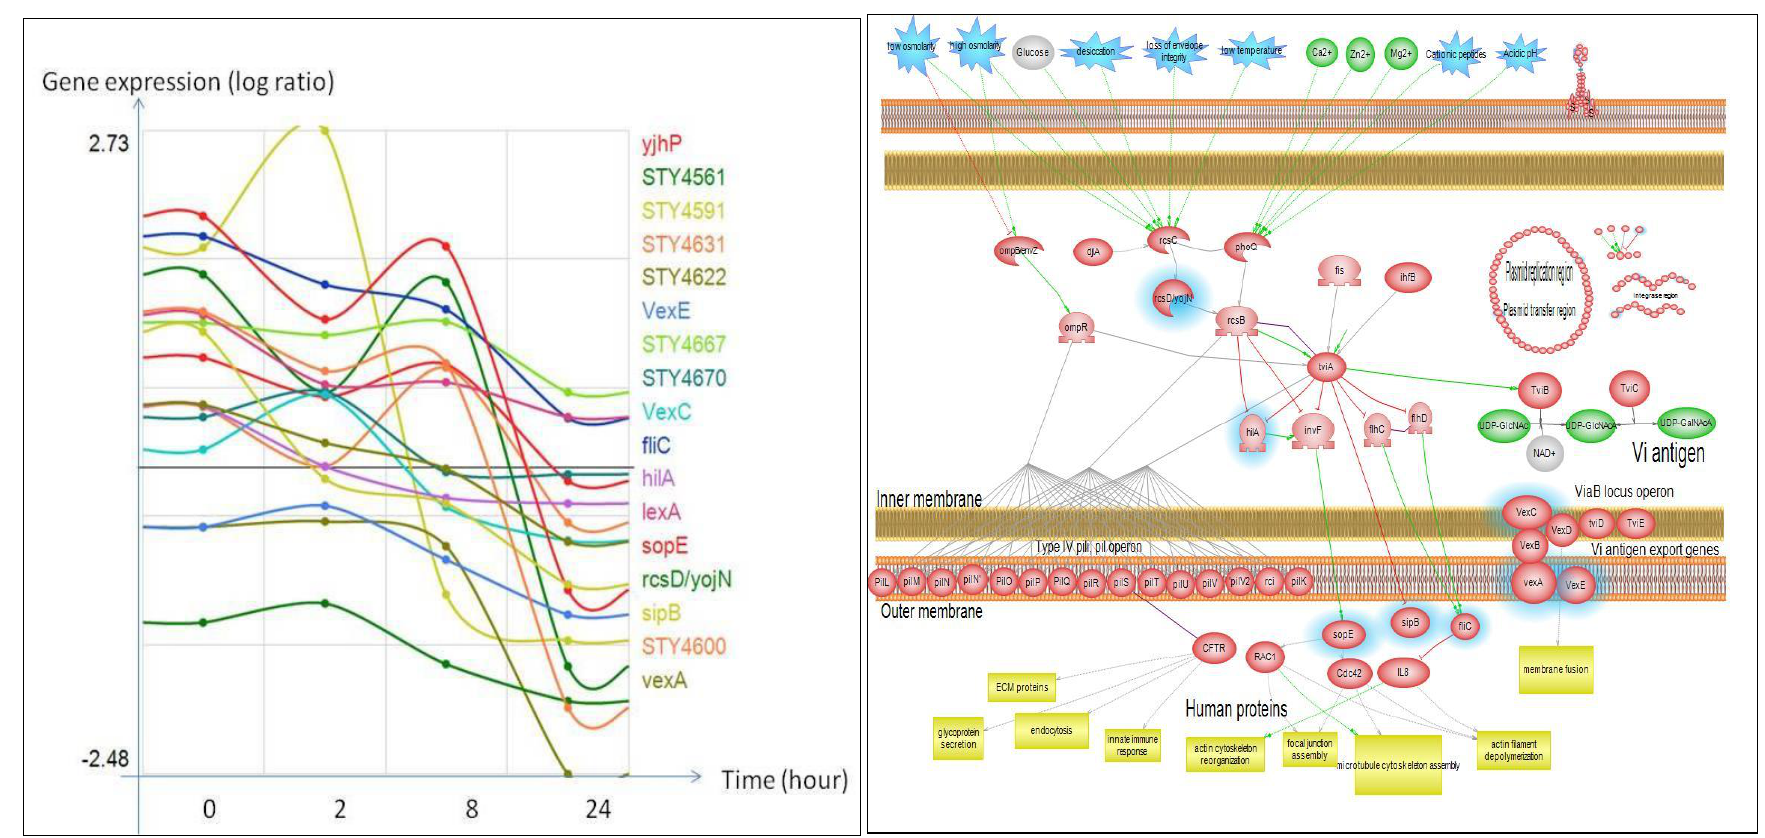
Figure 13: Cluster 7A. SPI-7 genes form one distinct gene expression cluster during the time-course of Salmonella infection of macrophages. Expression profile graph of cluster 7A shows that the expression of Vex genes/exopolysaccharide export genes is positively correlated. In this case, rcsD, hilA, sopE, sipB, fliC and some of the phage-related proteins have similar profile. According to [32], rcsB acts together with tviA which is encoded by the first gene of viaB locus in order to activate viaB transcription from the tviA promoter. Unfortunately, tviA is not measured on the chip and thus, its profile could not be